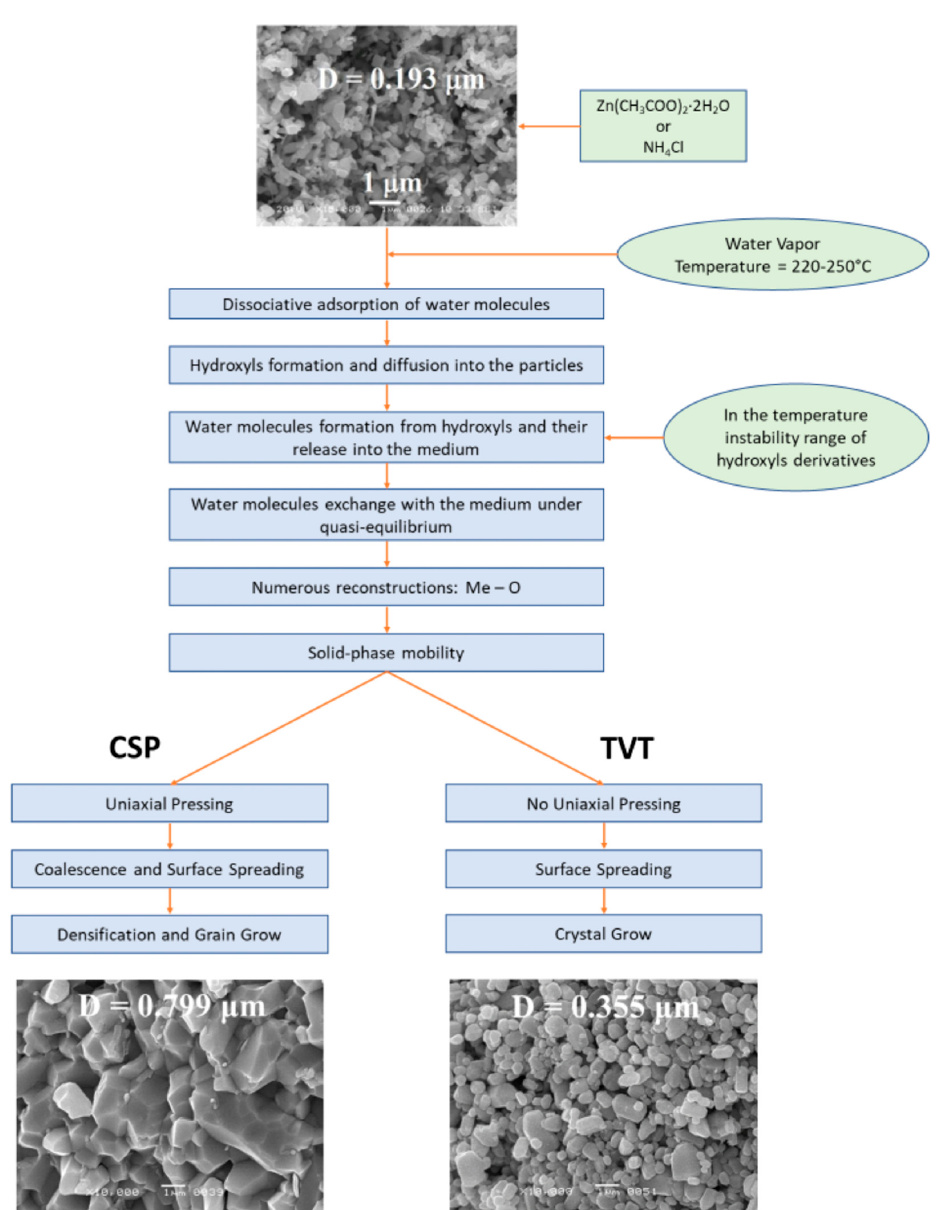
Figure 8. Scheme of the interaction of ZnO crystals with water vapor in the presence of activating additives in the CSP and TVT processes.